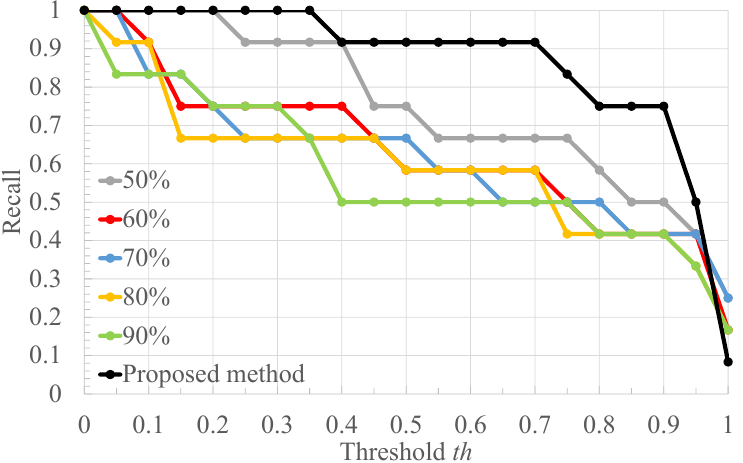
Figure 13. The recall of the method based on three-value classification (the percentage classified as moderate RRI = 50, 60, 70, 80, 90%) and the proposed